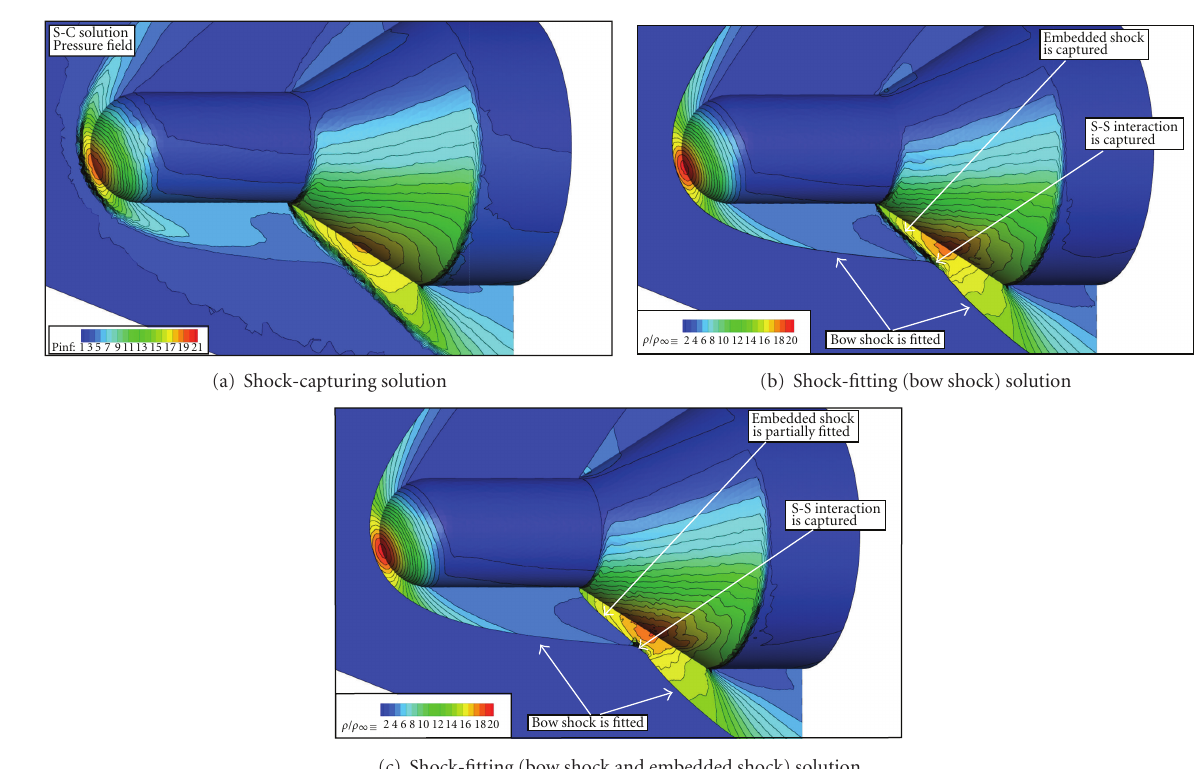
Figure 12: Supersonic ( M ∞ = 4 . 04) flow past a cylinder with conical flare: pressure isocontours predicted by the shock capturing and shock fitting